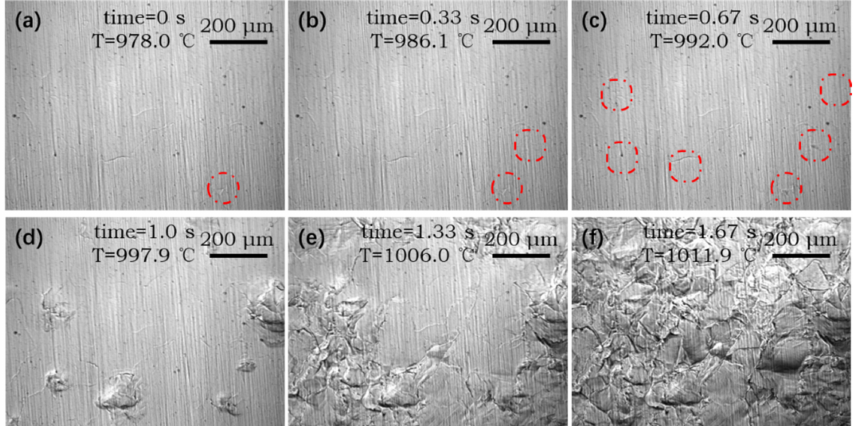
Figure 6. In situ observation of austenite transformation from ferrite during the heating process of subrapid solidified sample at a heating rate of 20 ◦ C/s: ( a – f ) are snapshots at 0s, 0.33 s, 0.67 s, 1.0 s, 1.33 s, and 1.67 s from 978 ◦ C, respectively. Visible nucleation sites are denoted in red circles. Typical CLSM pictures of austenite growth during isothermal process are shown in Figure 7. Compared with the heating process, there were some obvious features during isothermal process at 1300 ◦ C. First, some surface relief within grains disappeared and the grain boundaries became clearer, as indicated by region I. The migration of grain boundaries can be identified in Figure 7c (region II). This is direct evidence of grain growth by boundary migration during isothermal process. After being held at 1300 ◦ C for 180 s, the average austenite grain size of subrapid solidified sample reached ~120 µ m, which is close to 124 µ m of Nb microalloying steel [35] produced by the CASTRIP ® (Castrip ® LLC, Charlotte, NC, USA) process and 117 ± 44 µ m of dual phase steel [29] produced by the dip